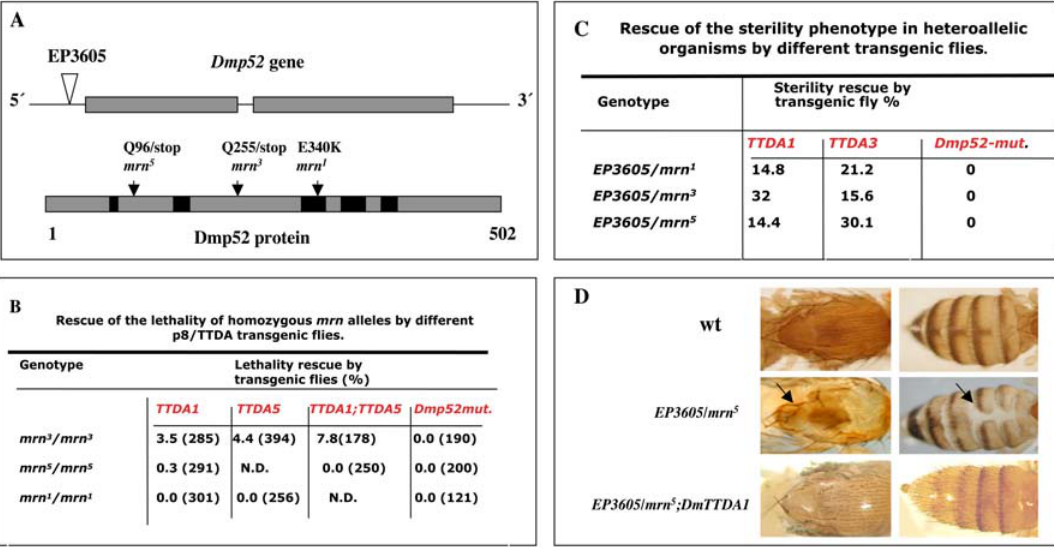
Figure 1. Rescue of Dmp52(mrn) mutants by transgenic flies overexpressing Dmp8/TTDA . (A) Schematic diagrams of the Dmp52 mutant alleles used in this work. An EP-transposable element inserted upstream of the first Dmp52 exon is indicated as an inverted triangle. The molecular nature and positions of the previously characterized point mutations [16] are also indicated. Black boxes represent regions conserved between human and fly p52. For more details on genotypic and phenotypic characterization, see reference [16]. (B) Rescue of lethality of homozygous mrn alleles by Dmp8/TTDA transgenic fly lines. The percentage represents the number of homozygous individuals recovered relative to the number expected with full complementation (number in parenthesis). Note that two transgene copies increased the number of viable organisms. (C) Rescue of the sterility phenotype in heteroallelic organisms by different transgenic lines. The percentage represents the number of individual flies that were fertile and had progeny that developed at least to larval stage. Ten to 25 flies were tested for each condition. Homozygous EP3605/EP3605 and heteroallelic adults ( EP3605/ mrn 1 , mrn 3 and mrn 5 ) are 100% sterile. Dmp52-mut is a transgenic line that expresses a double point mutant (E310KR314E) [16]. (D) Rescue of brittle-bristle and cuticle-deformation phenotypes in heteroallelic EP3605/mrn flies. 100% of adult heteroallelic flies have cuticular and bristle defects [16]. The presence of the Dmp8/TTDA transgene rescues both defects in all heteroallelic adult flies examined. The genotype is indicated in each panel and data quantification is shown in Table